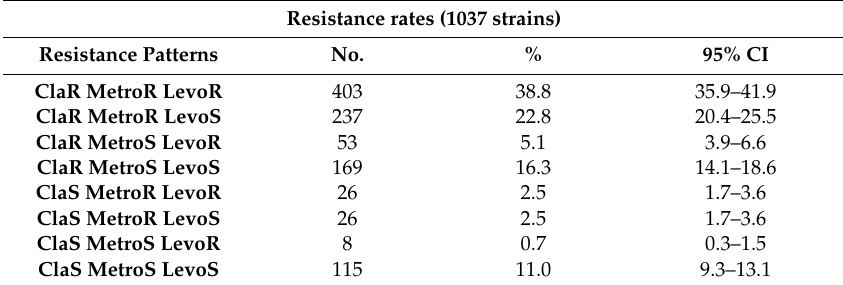
Table 2. Resistance patterns in Helicobacter pylori ( H. pylori )